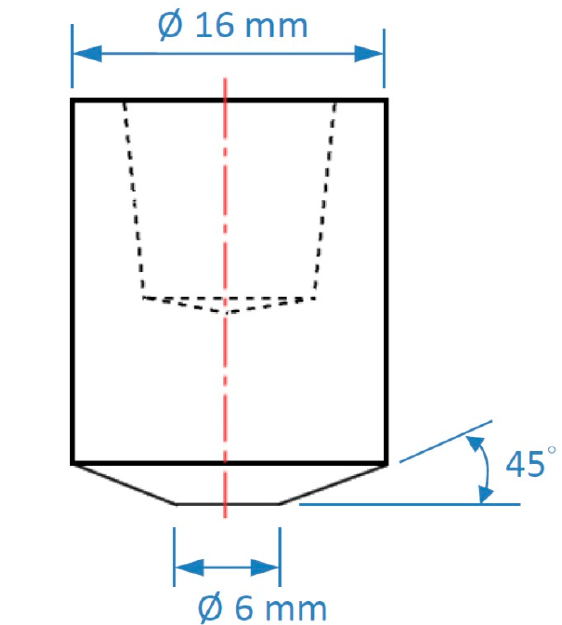
Figure 3. The geometry of the customized electrode tip.